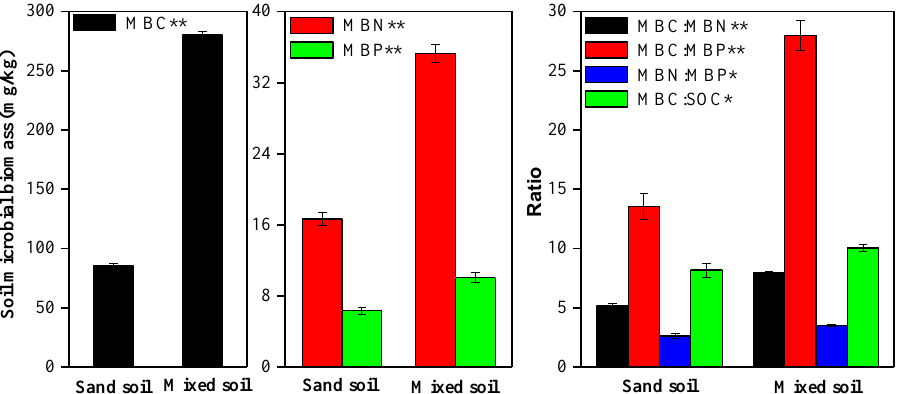
Figure 1. Soil microbial biomass and microbial biomass C:N:P stoichiometry and microbial quotient in sand vs. a mix of sand and feldspathic sandstone. * and ** indicate statistical significance at the 0.05 and 0.01 probability levels, respectively. Error bars are the standard errors ( n = 3).